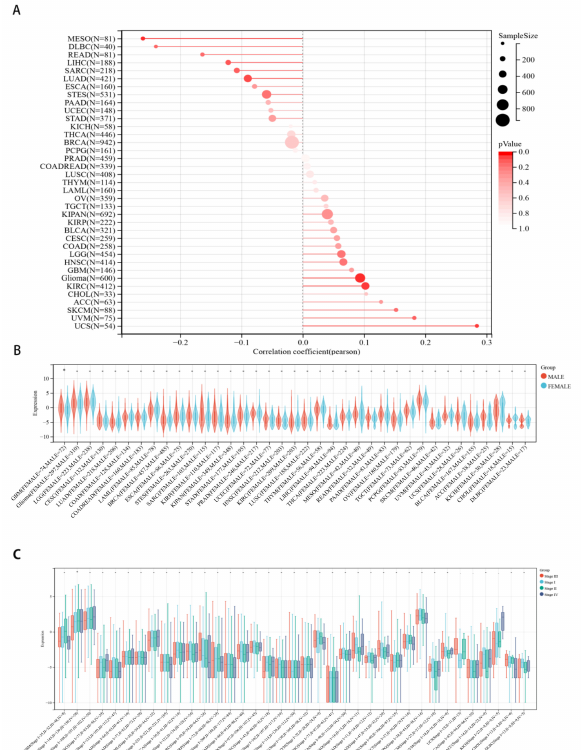
Figure 3. Correlations between CHD5 expression and pan-cancer clinicopathology. ( A ) The expression of CHD5 correlates with patient’s age in Glioma ( p = 0.02), KIRC ( p = 0.03), UCS ( p = 0.03) and MESO ( p = 0.01). ( B ) The expression of CHD5 was correlated with gender ( p < 0.05). ( C ) CHD5 was significantly differentially expressed across different stages of Glioma ( p = 0.04). * p <